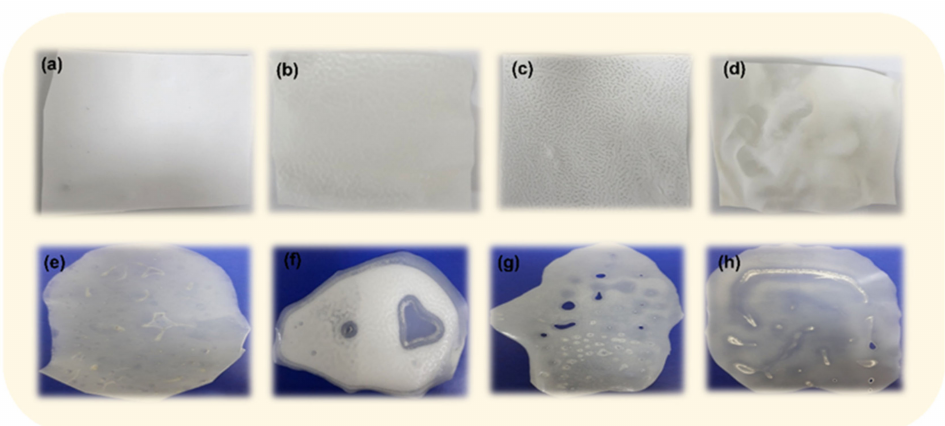
Figure 2. The effect of the additive addition in PESU-based solution before membrane preparation in wet solution casting: ( a ) without additive, ( b ) with 1%, ( c ) 2%, and ( d ) 5% of L-31; and in dry solution casting: ( e ) without additive, ( f ) with 1%, ( g ) 2%, and ( h ) 5% of L-31.